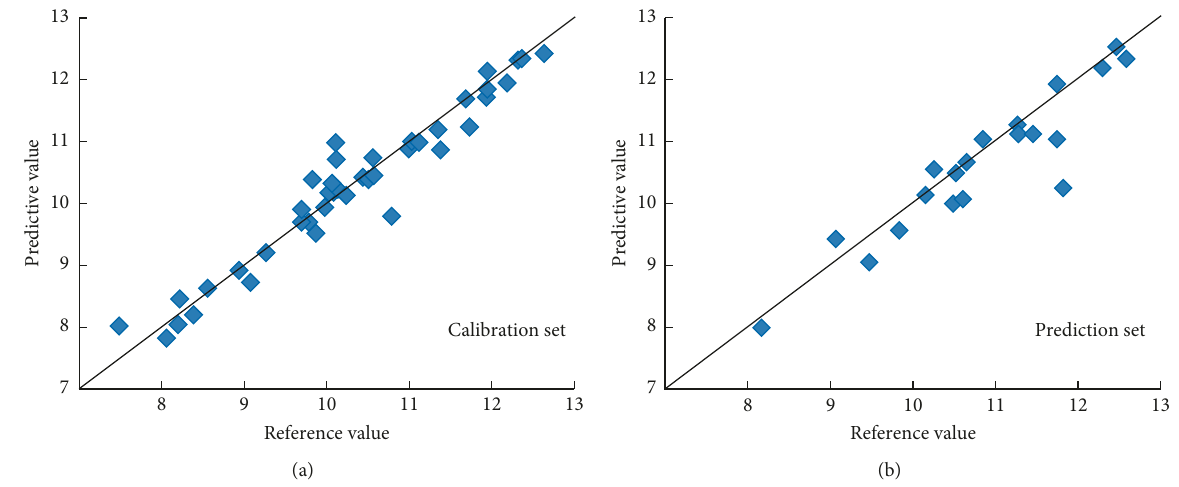
Figure 5: Predictive results in the calibration set (a) and prediction set (b) of the PLSR-6 Table 6: Validation and evaluation results of SVR models.